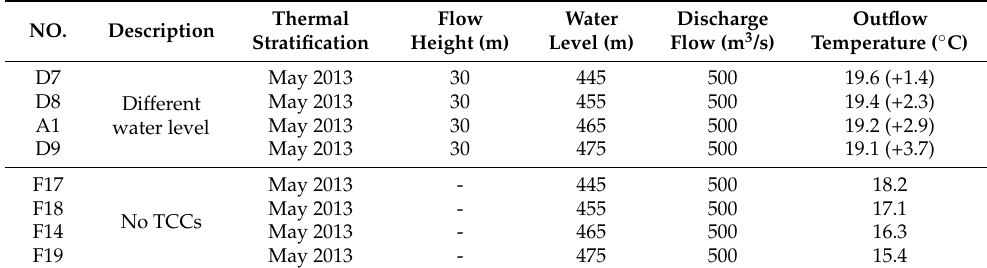
Table 7. Different water level test scenarios and results.